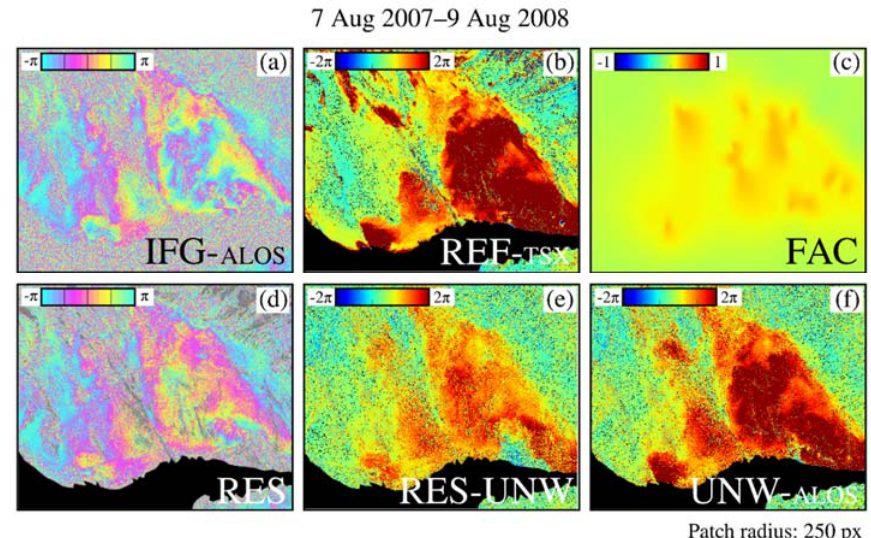
ground range resolution, 24 ‐ day repeat cycle) covering 2 cycles. ( a ) IFG ‐ RSAT ‐ 2, to ‐ be ‐ demodulated interferogram (wrapped); ( b ) REF ‐ TSX, reference interferogram (unwrapped); ( c ) FAC, demodulation factor; ( d ) RES: demodulation residual (wrapped); ( e ) RES ‐ UNW: demodulation residual (unwrapped); and ( f ) UNW ‐ RSAT ‐ 2, demodulated interferogram. The unwrapped phase in ( b , e , f ) is clipped to (cid:3399)2π . The demodulation patch radius is 200 pixels.